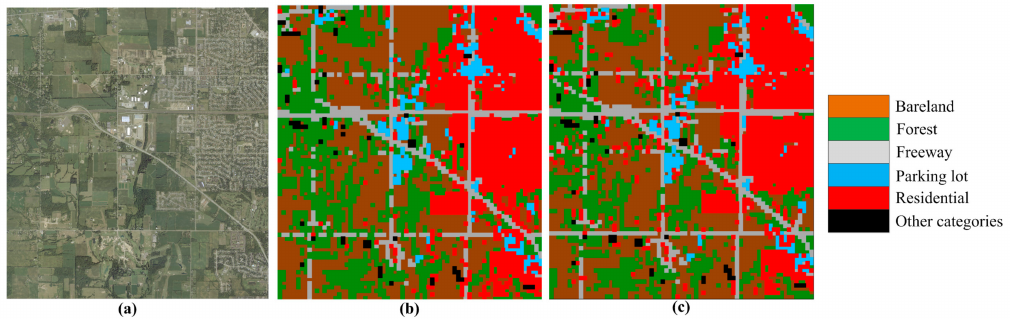
Figure 17. Semantic annotation of SIRI-WHU dataset. ( a ) Original image; ( b ) annotation result of SIRI-WHU dataset with color-boosted saliency-guided rotation invariant BOVW representation with parameter transfer corresponding to Table 5; and ( c ) ground truth image.